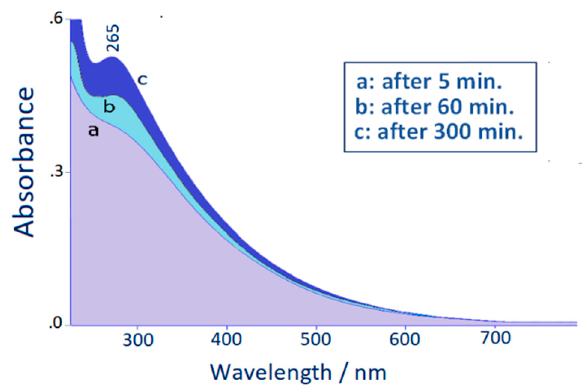
Figure 1. UV-vis absorption spectra of the aqueous sample of palladium nitrate, after different times from the dissolution (optical path length (OPL) = 1 cm).